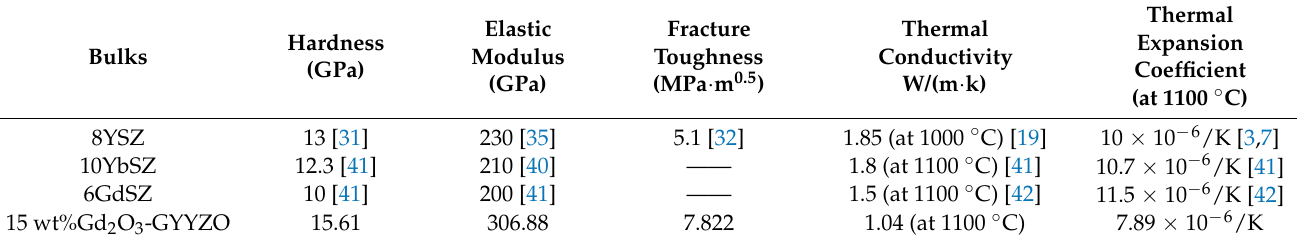
Table 8. Properties of ceramics used in thermal barrier